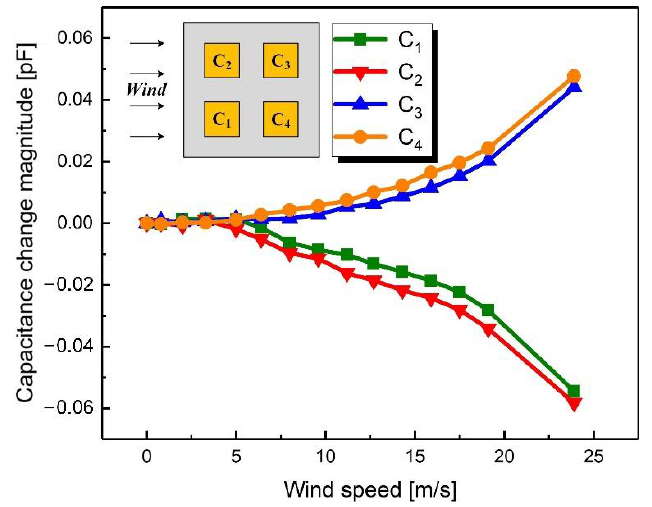
Figure 9. Measured capacitance change magnitudes when the wind speed varied from 0 m/s to 23.9 m/s with a fixed wind direction of 0°.